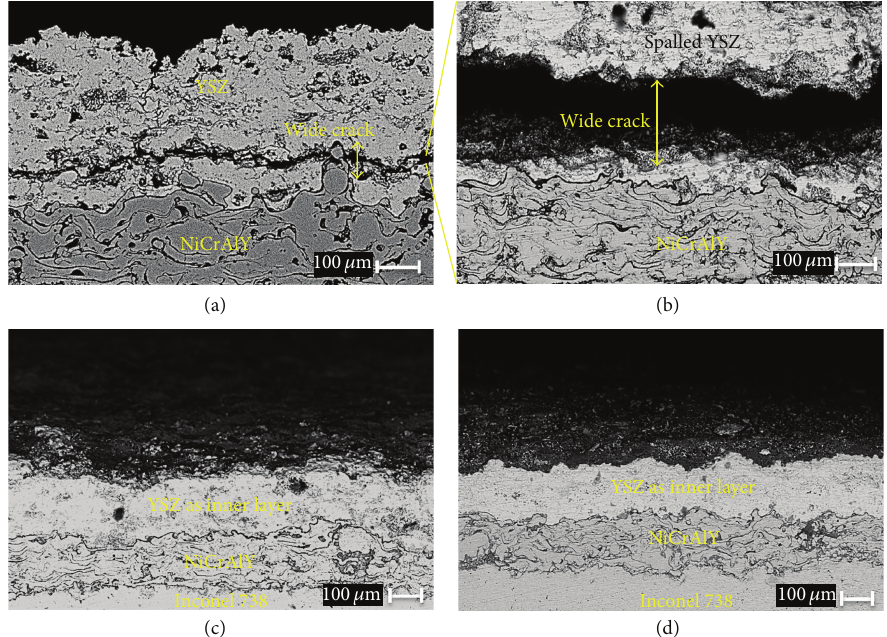
Figure 9: Cross-section of the coatings after hot corrosion testing at 1000 ∘ C. (a, b) Conventional YSZ coating, (c) YSZ as inner layer of YSZ/normal Al 2 O 3 coating, and (d) YSZ as inner layer of YSZ/nano-Al 2 O 3